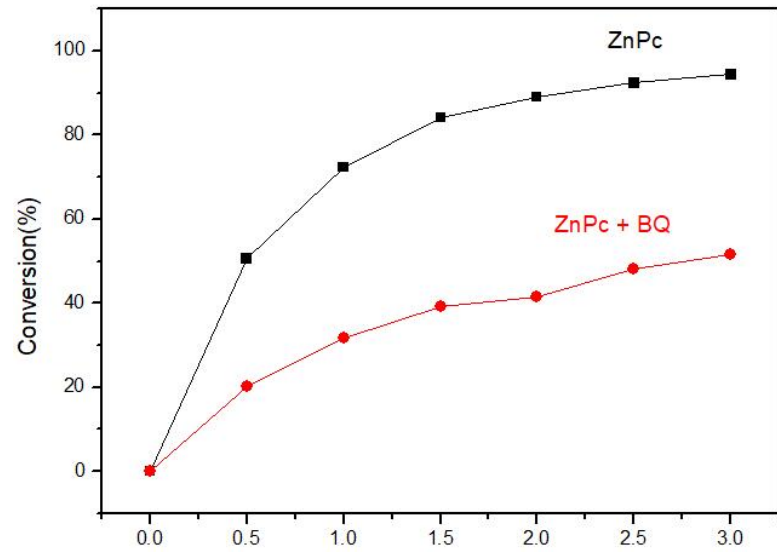
− Radical trapping Figure 9. •O 2 − Radical trapping experiments. Figure 9. •O 2 − Radical trapping experiments. Figure 9. • O 2